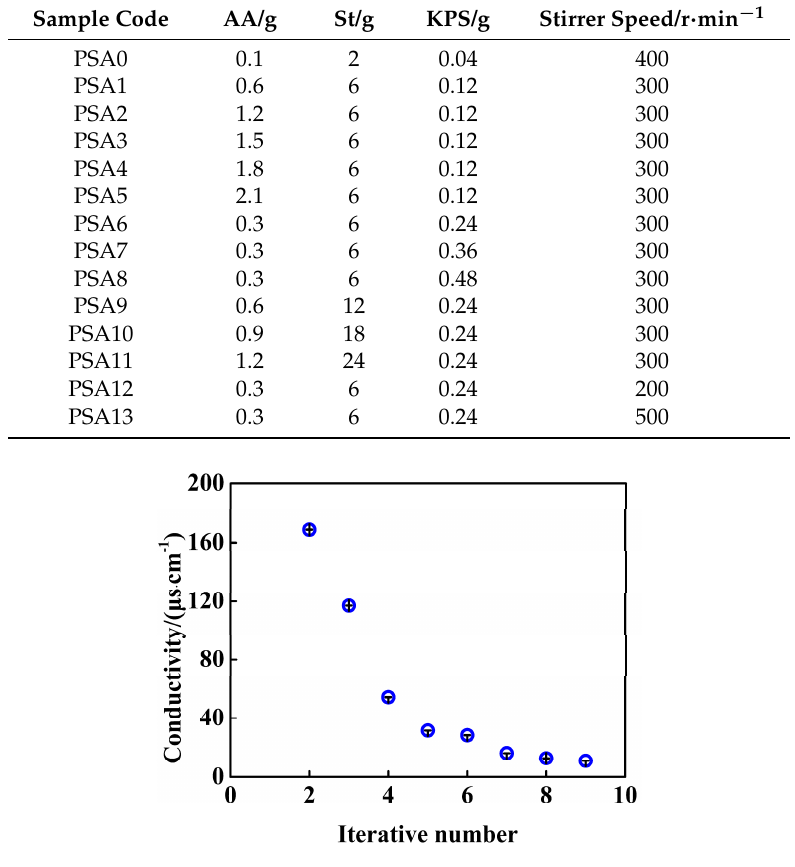
Figure 1. Dependence of conductivity of the PSA supernatant on the number of dispersion– centrifugation processes, a case of PSA0. processes, a case of